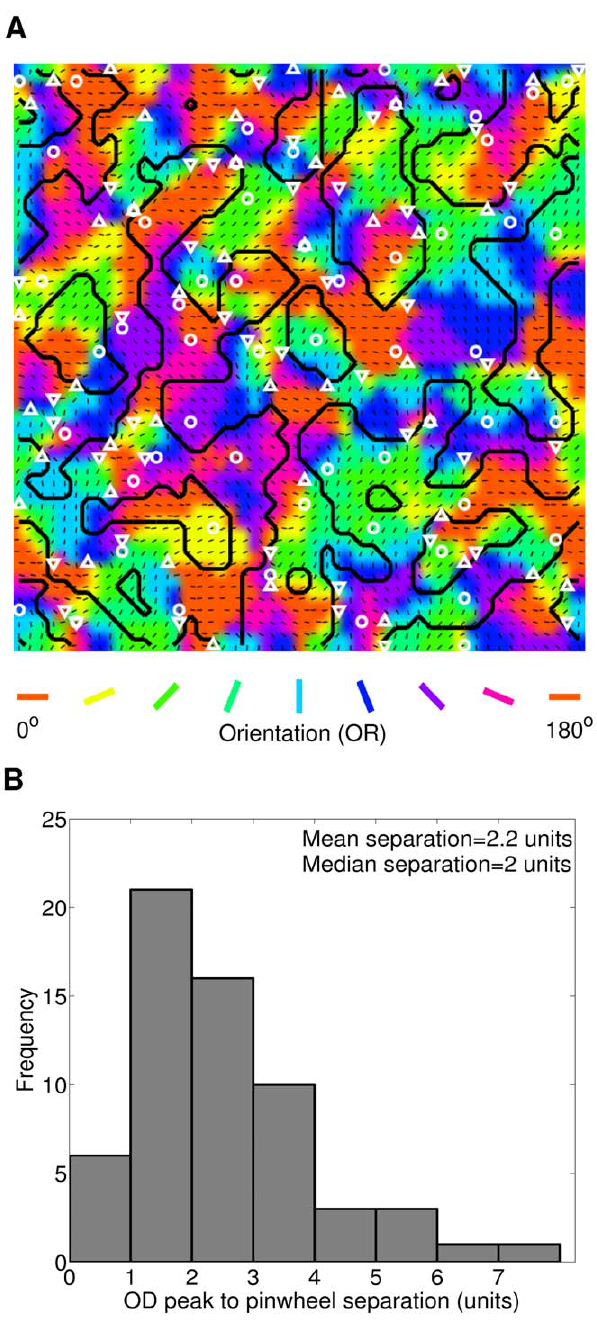
Figure 7. OR map superimposed with OD map contours. (A) Binocular OR map using color code scheme in 0 u to 180 u scale with superimposed OD map contours marked with thick black lines. The black color bars are oriented at cell’s binocular preferred OR. The OD peak points are marked with white color circle markers. The pinwheel singularities are marked with: (i) white color up pointing triangle markers for positive pinwheel singularities and (ii) white color down pointing triangle markers for negative pinwheel singularities. The OD peak points appear on/near the pinwheel singularities. (B) Histogram of OD peak points to pinwheel separation across the model cortex. The mean separation is 2.2 units and median separation is 2 units.